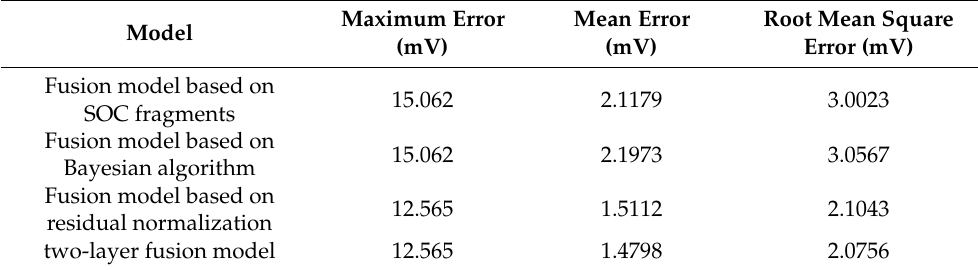
Figure 5. Simulation error comparison of models under the same UDDS. Table 6. Errors of the four fusion